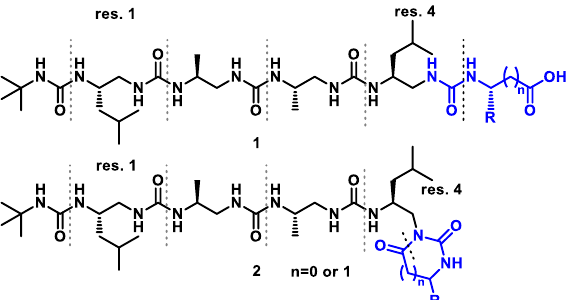
Figure 1. C-terminal-modified oligourea foldamers. The numbering of residues is carried out from the N- to the C-terminus, in contrast to what is usually used in the literature.